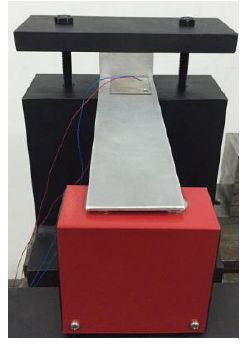
Figure 16. Single-beam system. Table 2. Aluminum beam characteristics.